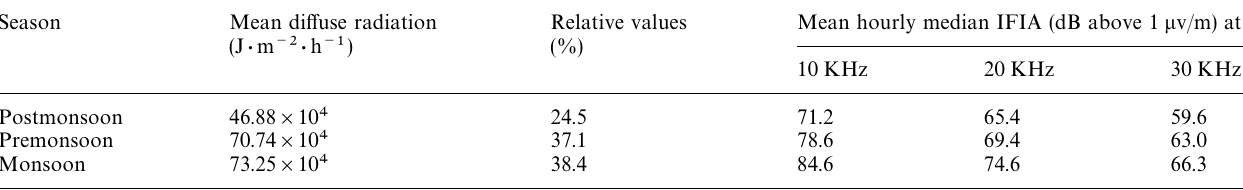
Table 7. Seasonal values of diffuse radiation and IFIA Season Mean diffuse radiation